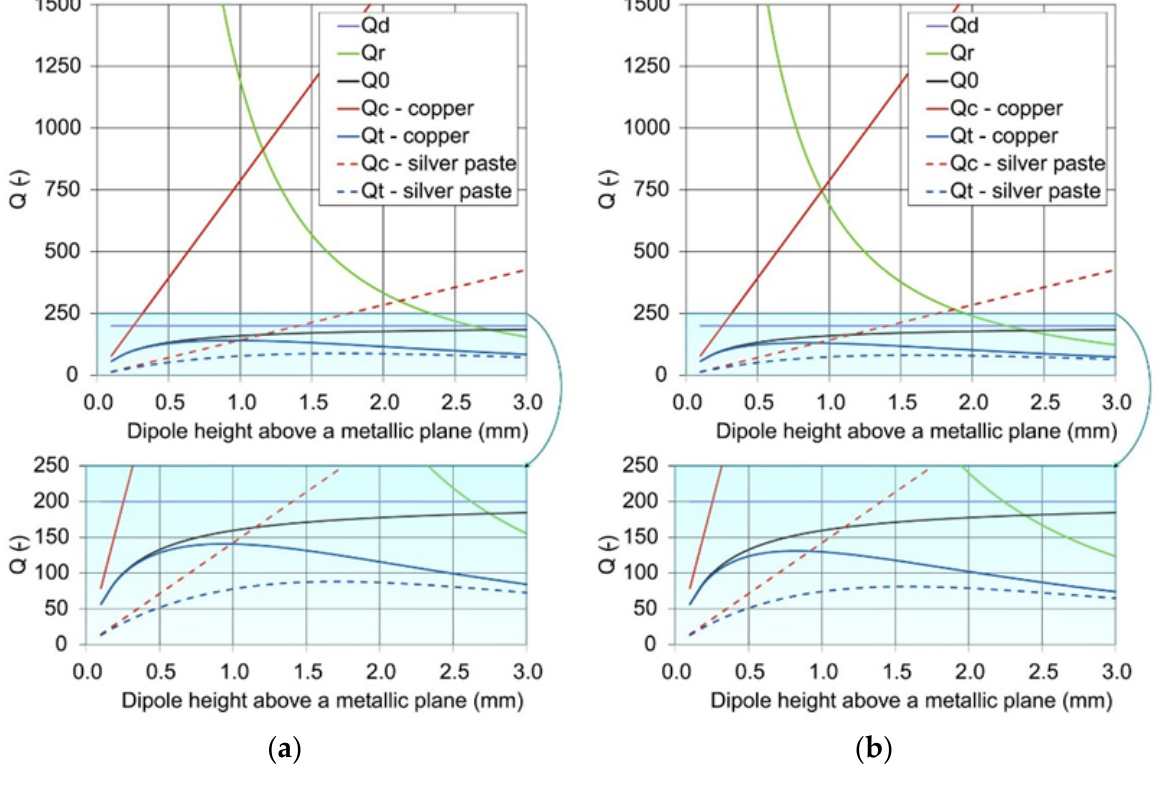
Figure 2. Quality factors vs. height of ( a ) a narrow dipole 46 × 0.2 mm 2 and ( b ) a wide dipole 46 × 1 mm 2 situated on a foam substrate above an infinite metallic plane for conductivity of copper (5.8 × 10 7 S/m) and silver paste (1.6 × 10 6 S/m). Intersection of the Q 0 and Q r curves correspond to critical coupling and deep resonant minima on the RCS curve.